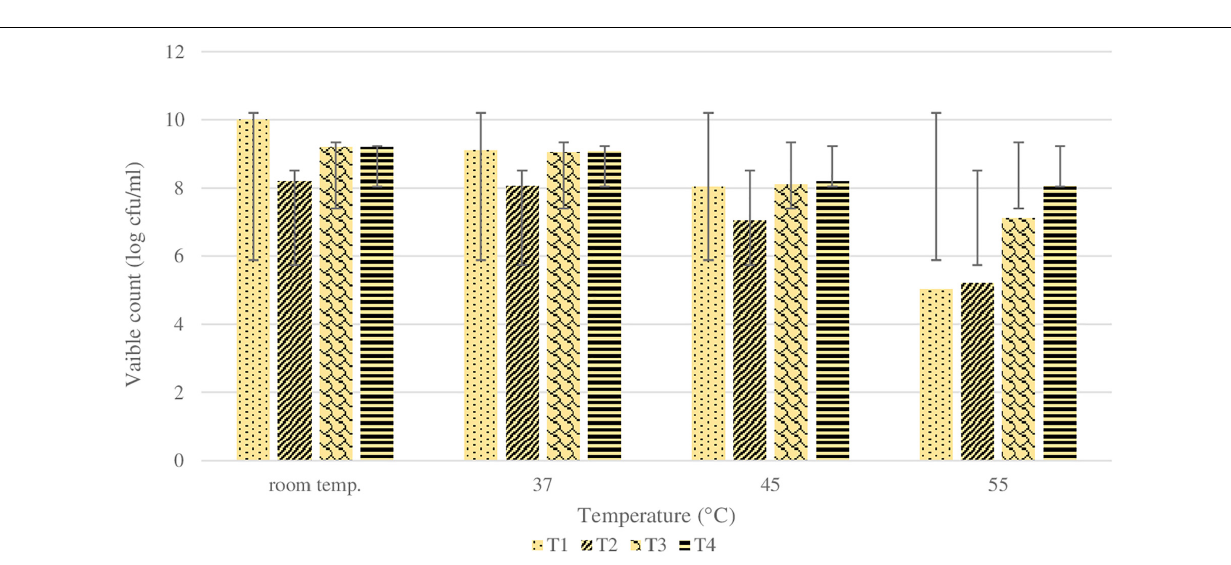
FIGURE 7 | Changes in viability (cell count) of plain or coated L. rhamnosus cells after exposure to different temperature; room temperature, 37, 45 and 55 ◦ C for 30 min. Tl : plain L. rhamnosus, T2: coated cells with BSP/Glucomannan, T3: coated cells with BSP/Alginate and T4:coated cells with